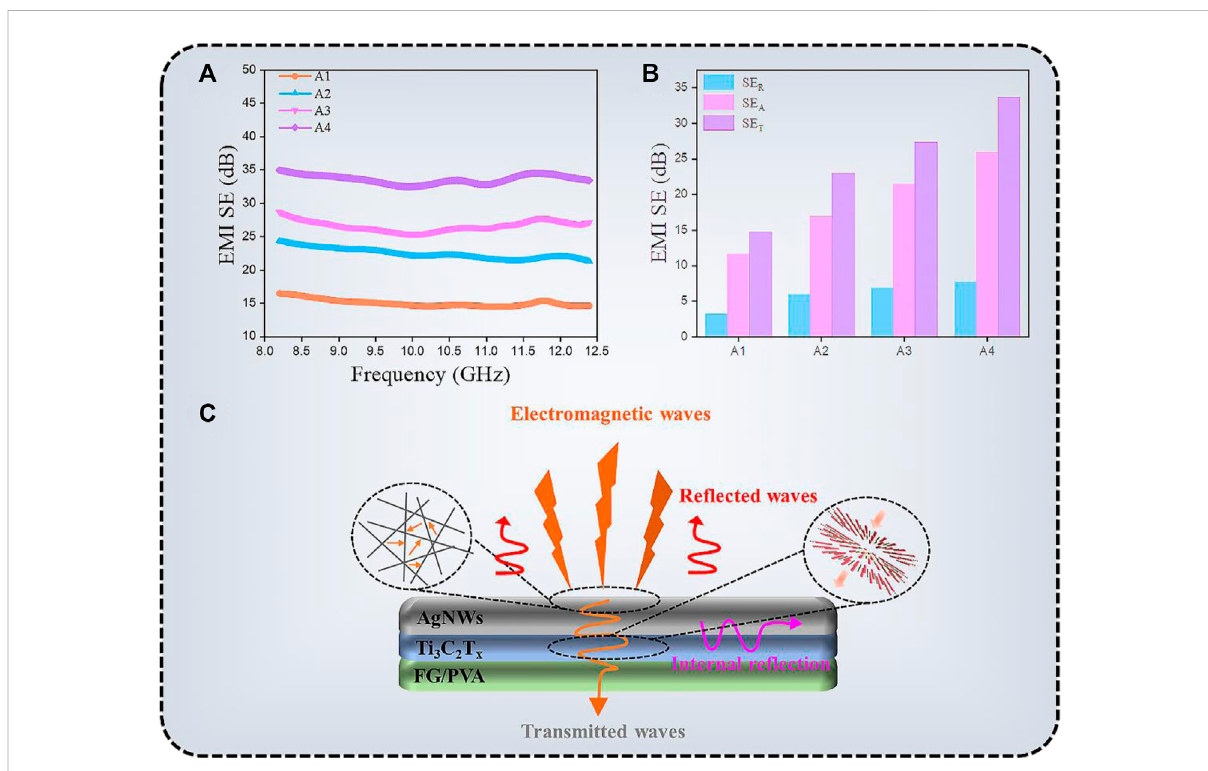
FIGURE 8 (A) EMI shielding performance, (B) EMI SE T , SE A , and SE R values, and (C) the mechanism of EMI shielding of AgNWs/Ti 3 C 2 T x -FG/PVA fi